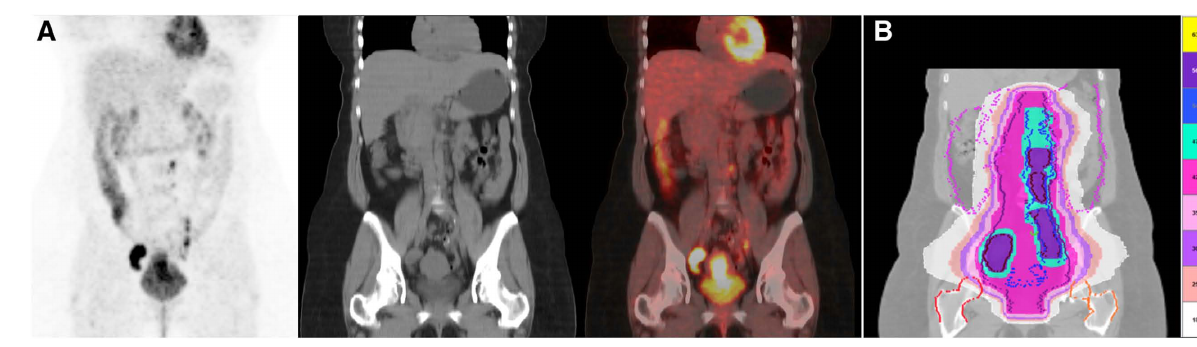
FIGURE 1 |A 62-year-old woman with a FIGO IIB cervical cancer, treated with concomitant cisplatin based chemotherapy and radiotherapy. Image shows the radiotherapy contouring process on fused planning-CT and FDG-PET/CT images. Contouring is done on